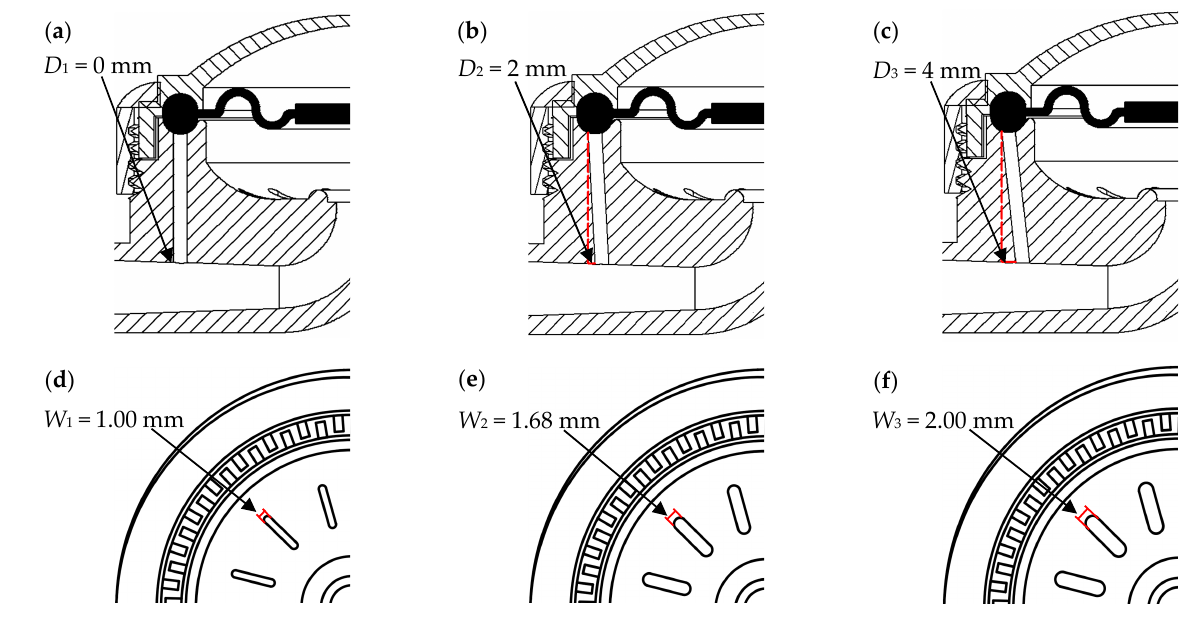
Figure 2. Schematic diagram of the variation in different ascending channel offset distances ( D ) ( D 1 ,